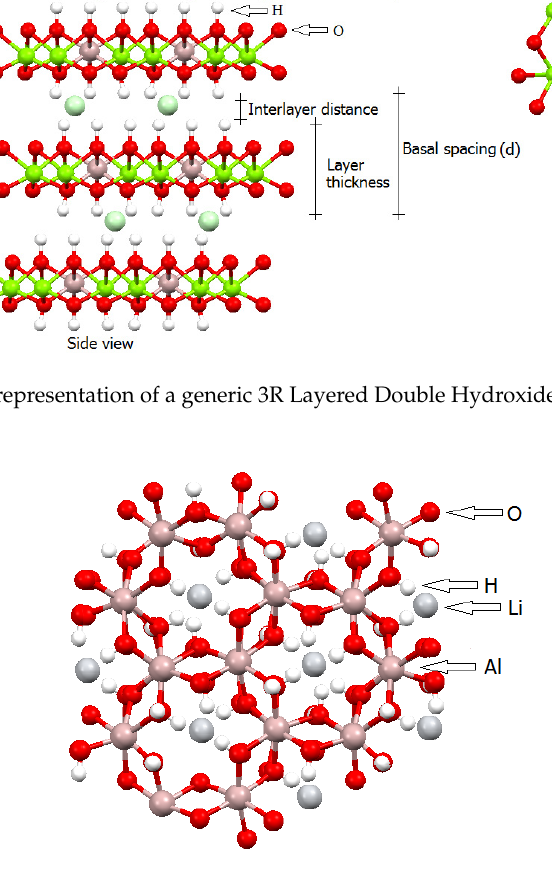
Figure 3. Top view of a single [LiAl 2 (OH) 6 ]A·zH 2 O layer (A = Cl − , Br − , NO 3 − , etc .) [36,37].